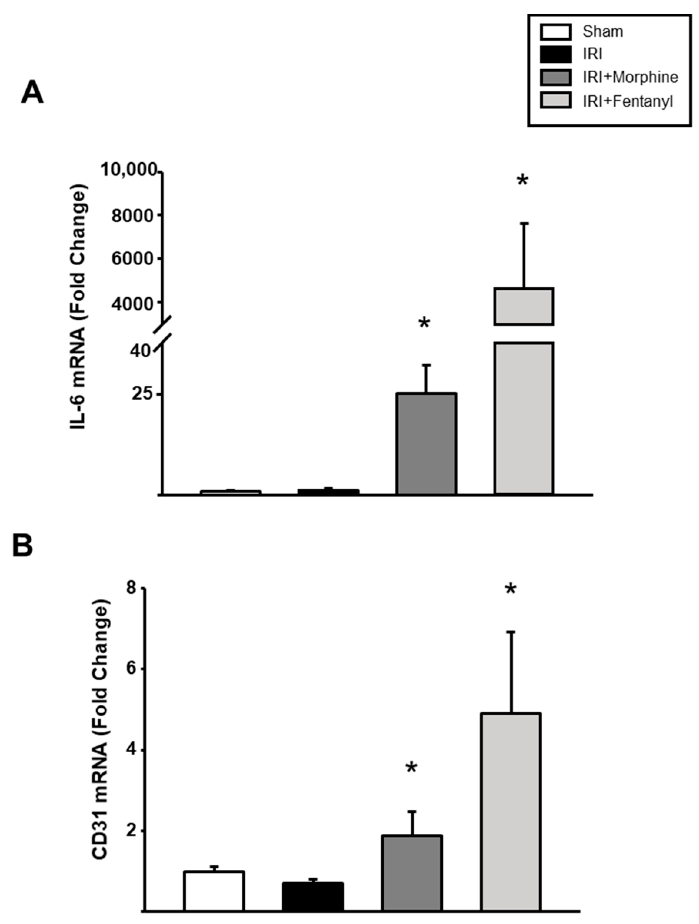
Figure 5. IL-6 and CD31 expression levels after IRI injury. Quantitative RT-PCR evaluation of renal expression of IL-6 ( A ) and CD31 ( B ) after ischemia-reperfusion with or without opioid preconditioning. HPRT was used as a housekeeping gene for normalization. Sham group is represented by the white bars, IRI by the black bars, IRI + morphine by the dark gray bars and IRI + fentanyl by the light gray bars. Values are means ± S.E.M. ( n = 6). * p < 0.05 vs. IRI.